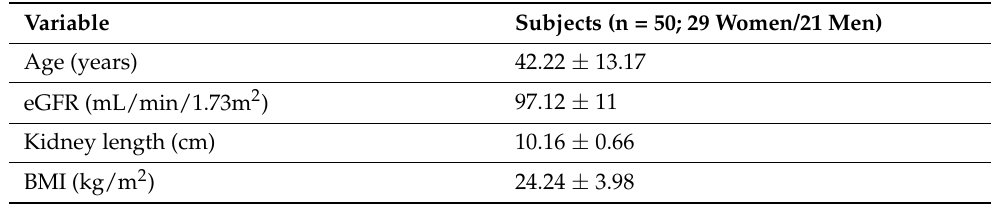
Table 1. Baseline